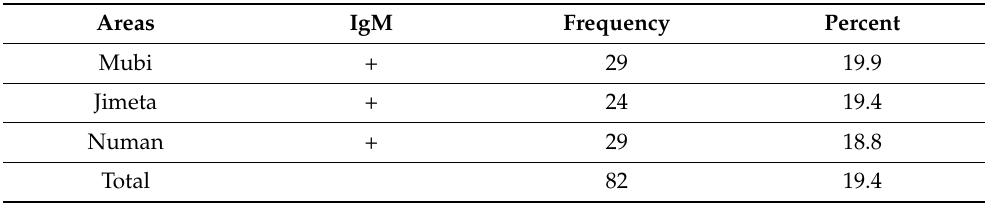
Table 2. ELISA detection of dengue IgM.